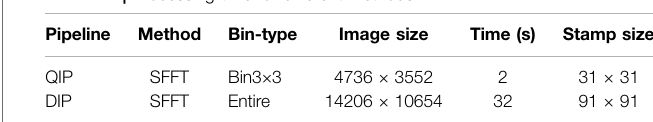
TABLE 2 | Processing time for different